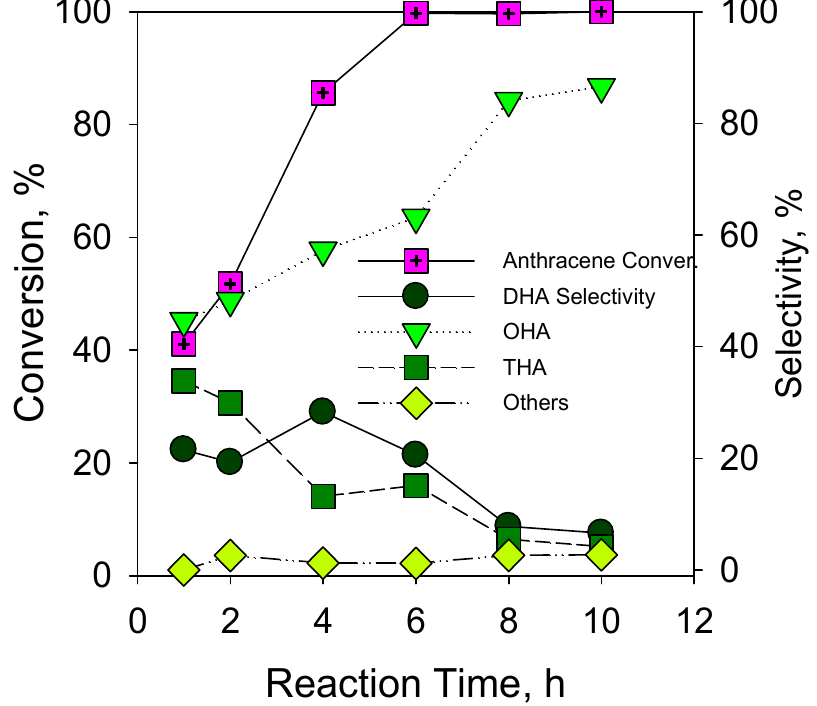
Figure 8. Effect of reaction time on hydrogenation of anthracene over 40% Ni/H β -zeolite catalyst. Catalyst weight: 0.5 g; Reaction temperature: 100 °C; Reaction pressure: 6.9 MPa; H partial pressure: 2.76 MPa; volume of the reactor: 50 mL; reaction time: 6 2